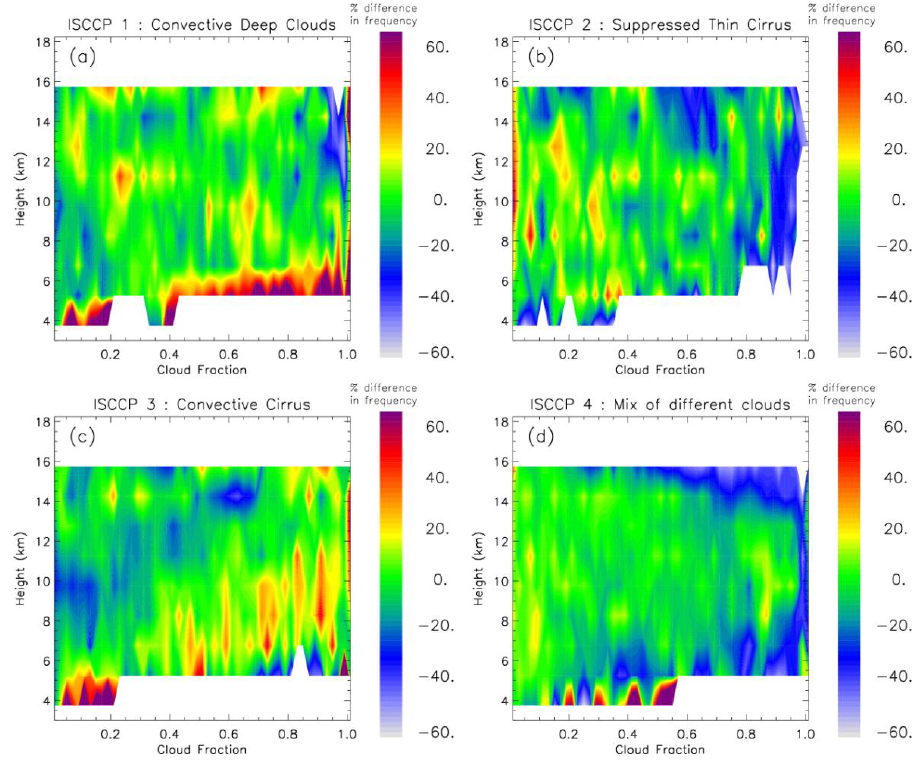
Figure 13: Percentage differences in cloud fraction distribution with respect to the HPDF of Fig. 5a for the ISCCP regimes: CD (a), STC (b), CC (c), and MIX (d).